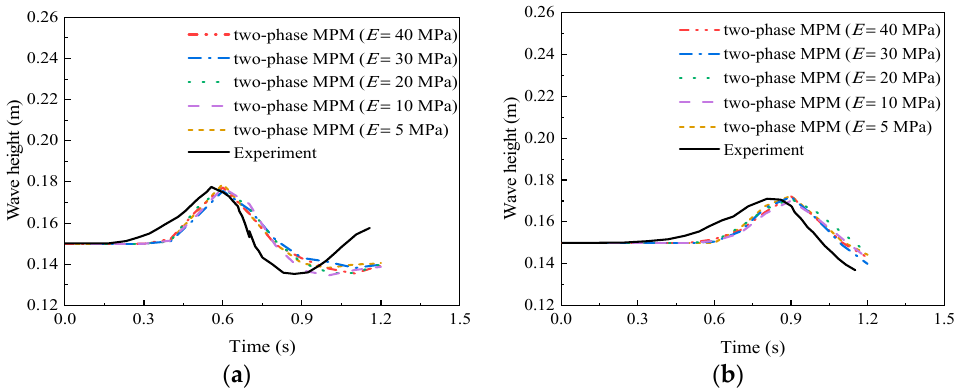
Figure 12. Influence of elasticity modulus of sliding sand: time history curve of the free water surface at two different locations: ( a ) X1 = − 0.3 m; ( b ) X2 = − 0.6 m. Additionally, the effect of Poisson ratio of sliding sand is investigated. Five Poisson ratios ( ν = 0.1, 0.2, 0.25, 0.3, and 0.4) are used in the simulation, and other conditions remain unchanged. Figure 13 displays the change in free water surface height over time at locations X1 and X2 for different Poisson ratios and displays the correlation of Poisson ratio. The numerical results show that the impact of Poisson ratio on the water wave is almost negligible for slow landslides.